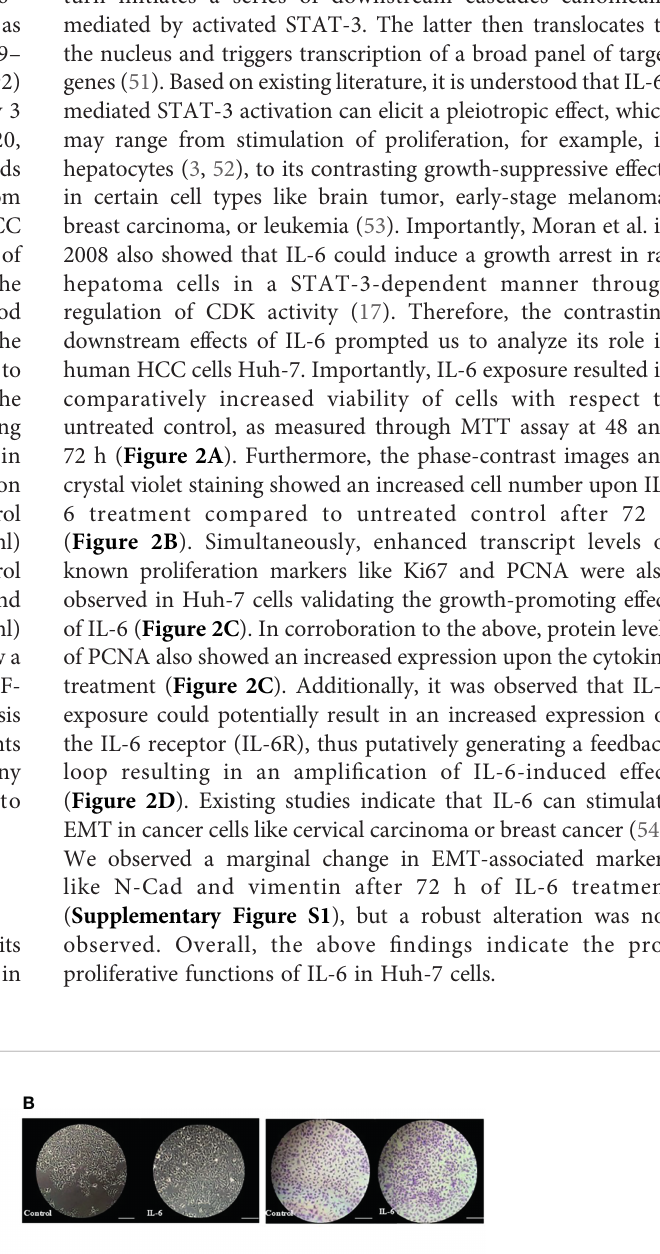
Figure 1B . The level of IL-6 in the control group was 0.81 (0.06 –